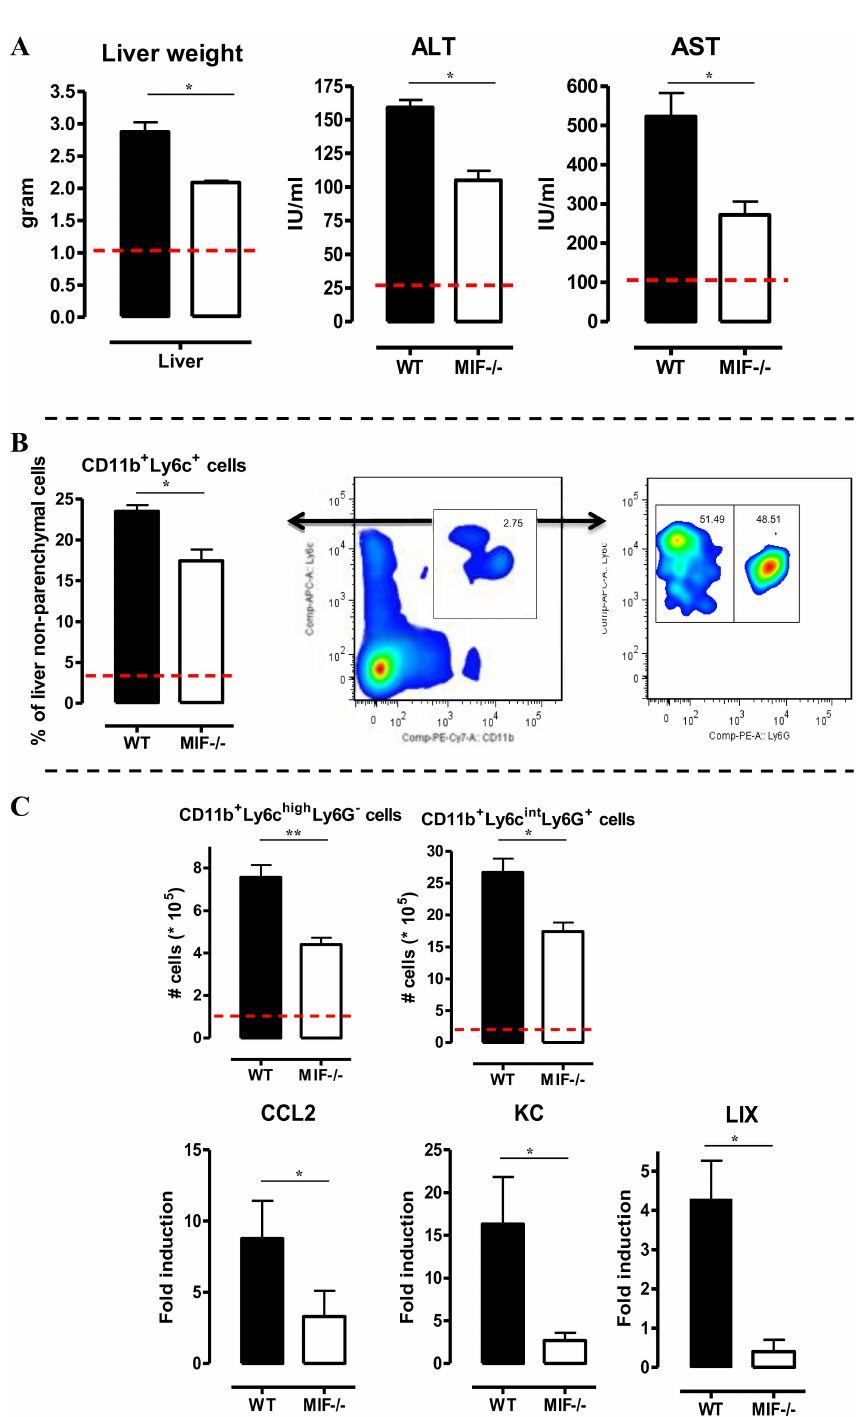
Figure 3. MIF deficiency reduces liver damage and alters liver cell composition during T.brucei infection. (A) Liver weight (left panel), serum ALT (middle panel) and AST (right panel) levels in Mif 2 / 2 (white bars) and WT (black bars) C57Bl/6 mice at day 25 p.i. (B) Representative liver immune cell gating strategy: Ly6c versus CD11b plot following gating on CD45 + and 7AAD- cells allows identifying CD11b + Ly6C + cells (middle panel). This population was plotted in a Ly6C versus Ly6G plot to distinguish CD11b + Ly6C high Ly6G 2 inflammatory monocytes and CD11b + Ly6C int Ly6G + neutrophils (right panel). Percentage of CD11b + Ly6C + cells within the liver CD45 + cells in WT (black bars) and Mif 2 / 2 (open bars) mice (left panel). (C) Number of CD11b + Ly6C high Ly6G 2 and CD11b + Ly6C int Ly6G + cells within the liver CD45 + cells (upper left panels). The dashed line represents values in non-infected mice. Total liver CCL2, KC (CXCL1) and LIX (CXCL5) gene expression levels in Mif 2 / 2 (white bars) and WT (black bars) mice at day 25 p.i. (lower panels). Gene expression levels are normalised using s12 and expressed relatively to expression levels of non-infected mice. Results are representative of 2 independent experiments and presented as mean of 3 individual mice 6 SEM (*: p-values # 0.05, **: p-values # 0.01).